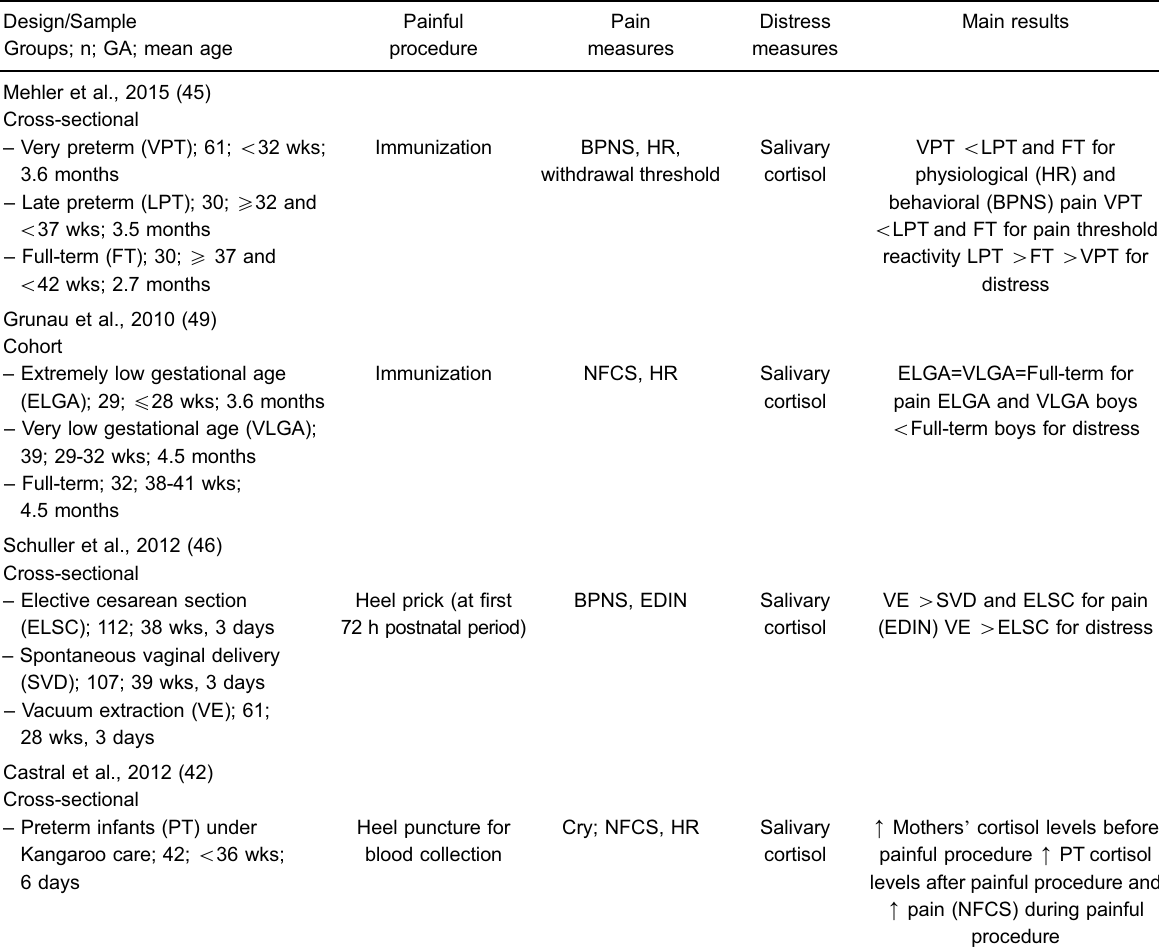
Table 3. Main fi ndings of cross-sectional and cohort studies on pain and distress responses in infants (n=4).